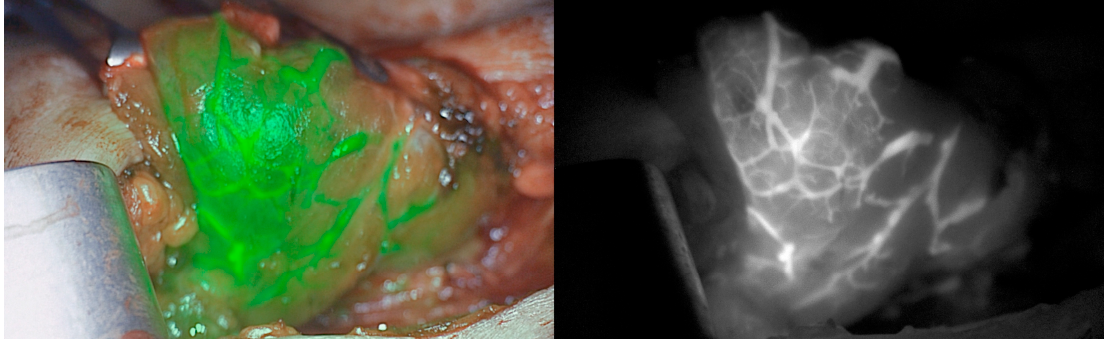
Figure 2. Thyroid gland after ICG application.